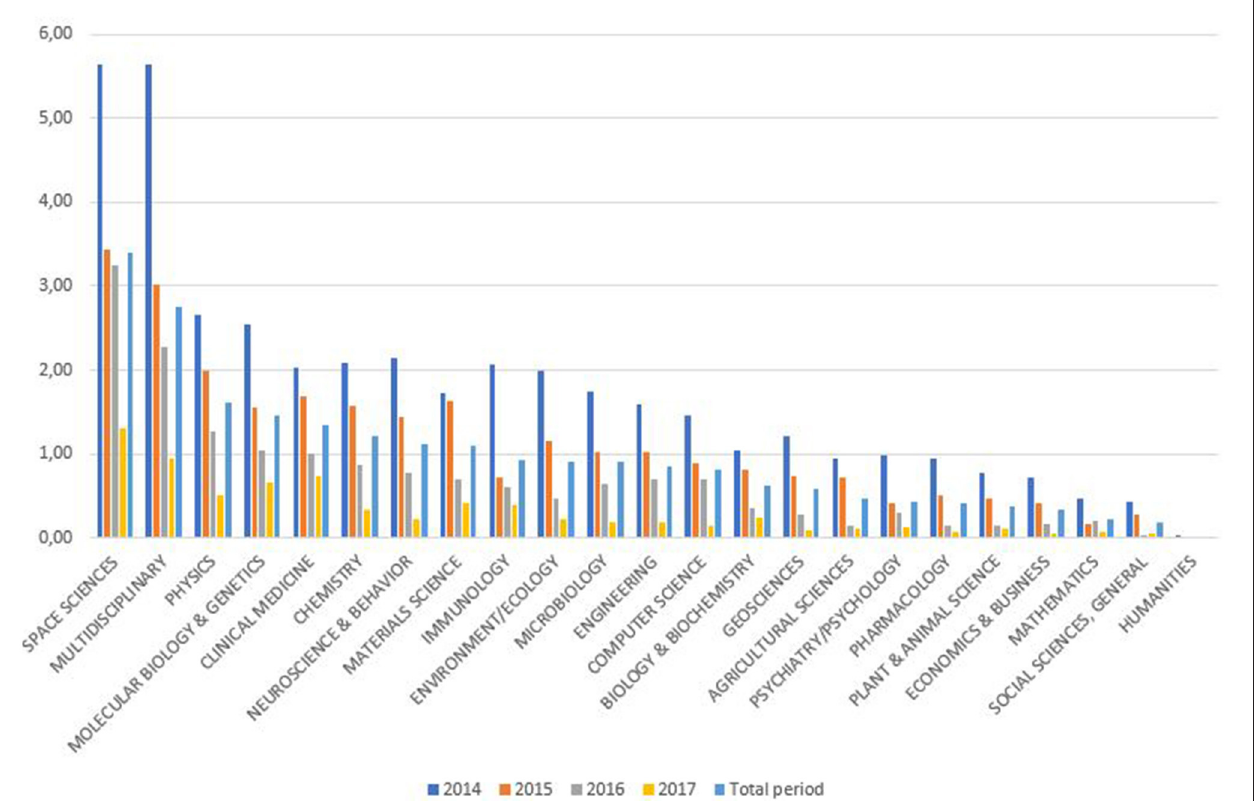
FIGURE 4 | Percentage of most-citedness in SUPE by Incites/Essential Science Indicators area.